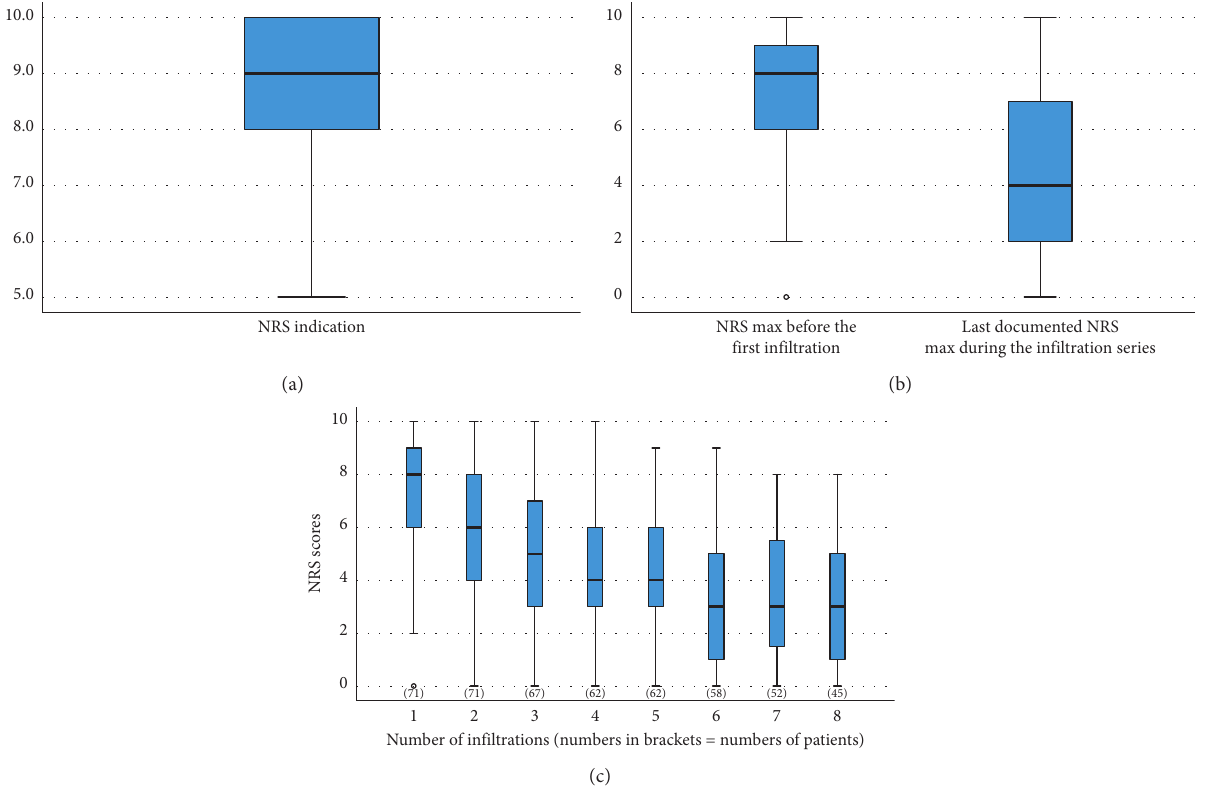
Figure 2: NRS indication, NRS beginning and ending, and NRS during the course of infiltration. (a) A boxplot showing the NRS score for the indication of infiltration series. N � 81, mean � 8.65 (SD ± 1.61), and median � 9 (IQR 8,10). (b) Two boxplots comparing the NRS score for maximum pain before the first infiltration and at the ending of infiltration series. A significant NRS reduction was achieved, p < 0 . 001. (c) This graphic shows the NRS scores during the infiltration series until data from at least 50% of initially treated patients was available. Numbers in brackets indicate the numbers of patients reporting NRS scores at that time point.